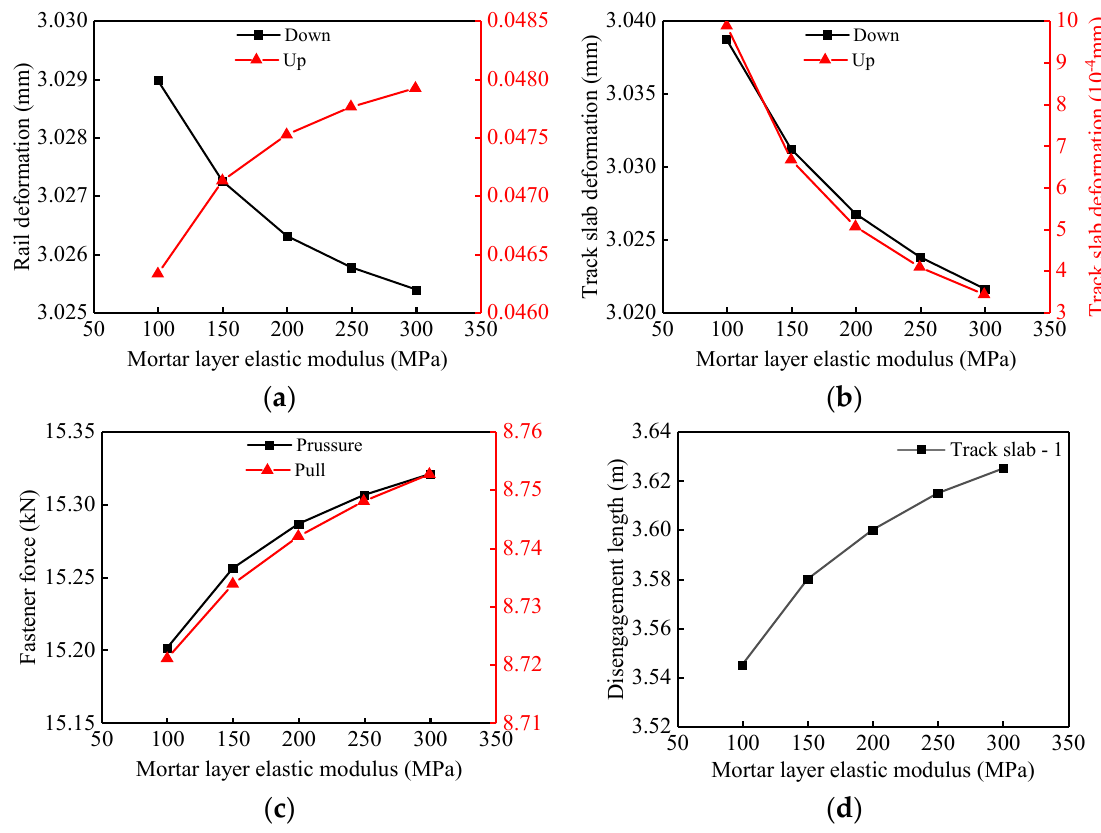
Figure 12. Effects of mortar layer elastic modulus on track structure: ( a ) variation of rail deformation; ( b ) variation of track slab deformation; ( c ) variation of fastener force extremum; ( d ) variation of track slab disengagement length.